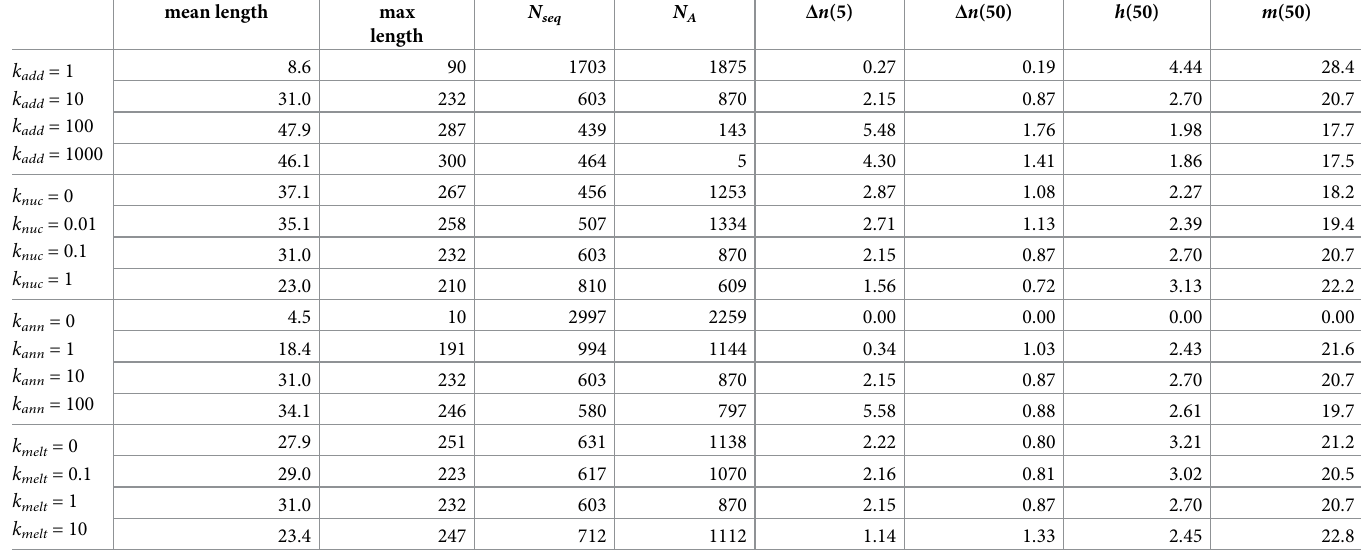
Table 3. Summary of quantities measured in simulation runs as a function of the rate variables. In each group of four runs, one rate constant is varied (as in the first column) and the other rates are set to their standard values in Table 1. mean